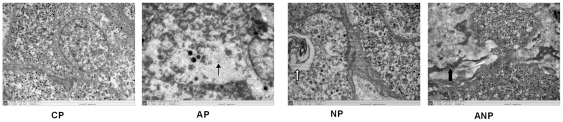
Electron micrograph of adrenal medulla in maternal rats.AMCC lined up tightly in order, containing round nucleus, abundant
chromatin granules, and mitochondrion with clear structures in CP rats.
Mitochondrion swelled, lipid increased and chromaffin granules decreased
in AP and NP rats (thin arrow). Cytoplasm lamellar-like structure
appeared in NP rats (hollow arrow); Lesions were alleviated and appeared
more collagen tissue, which divided adrenal medulla into island in AP
rats (thick arrow). (The magnification of the image is 10000
×).